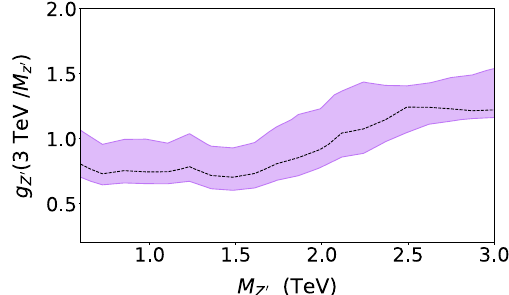
Fig. 21 Effects of theoretical uncertainties on bounds from the b - veto category of the ATLAS di-muon search with b -tagging [63].The dashed black line shows the central limit. The purple region falls between bounds obtained from upper and lower estimates of the cross- section accounting for systematic uncertainties. Toward the extreme left-hand side of the plot, our predictions become more inaccurate due / M 2 ) relative to unaccounted-for O ( M 2 Z Z (cid:2) / M 2 ) relative correc- Z Z (cid:2)